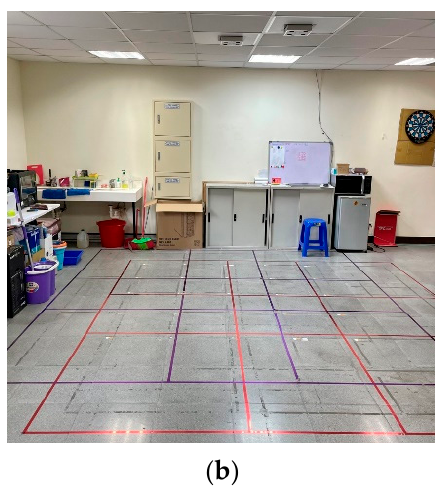
Figure 1. The deployment of a PIR sensor network: ( a ) a pair of PIR detectors and ( b ) the experimental scenario with grid zones.